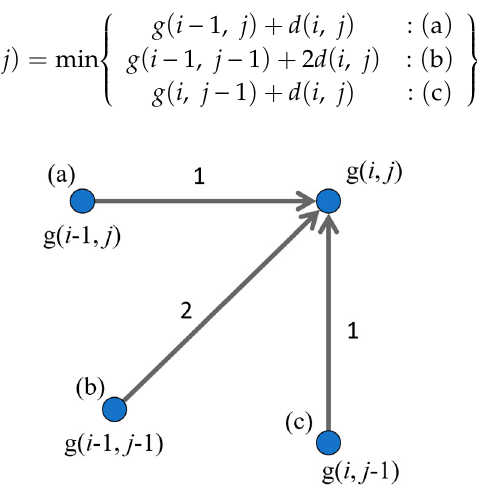
Figure 5. Definition of DP path. To calculate the accumulated distance, ( a ) to ( c ) indicates a pattern of distance in i-j coordinates space. Each number shown in ( a ) to ( c ) expresses the weighted score for calculating the distance by the following Equation (8).